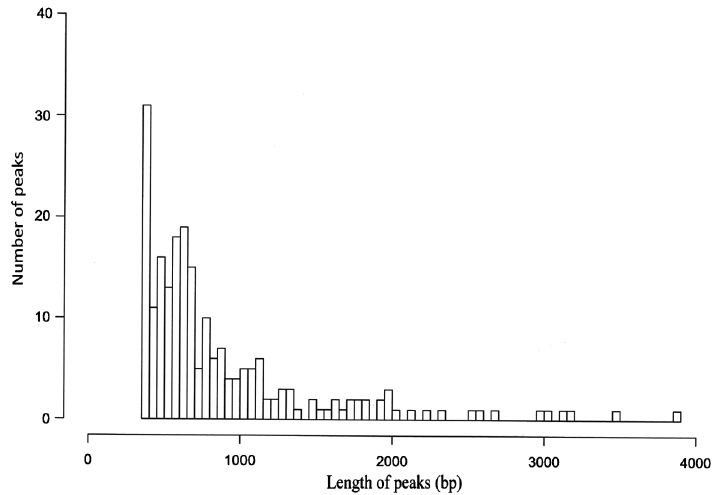
Figure 1. ChIP-seq peak distribution (distance) of H3K9me3 from membranous nephropathy